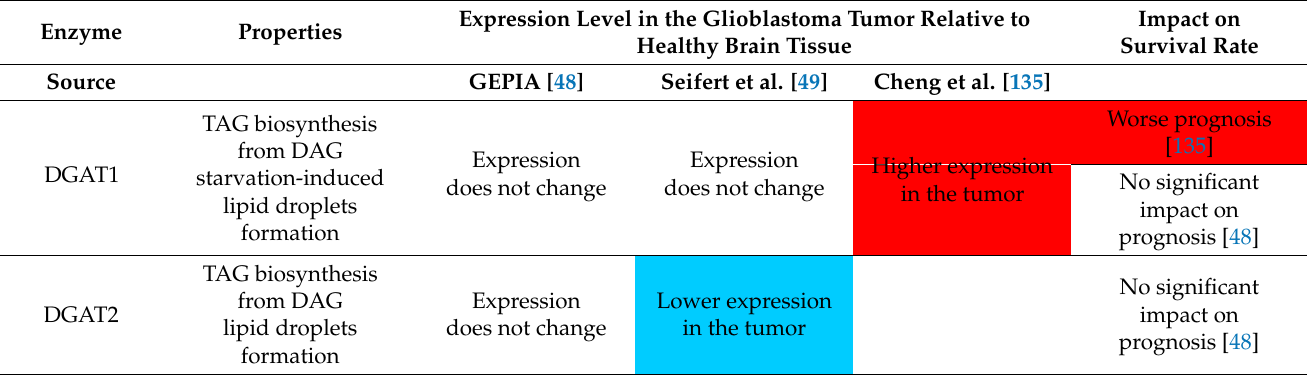
Table 12. Characteristics of enzymes involved in TAG